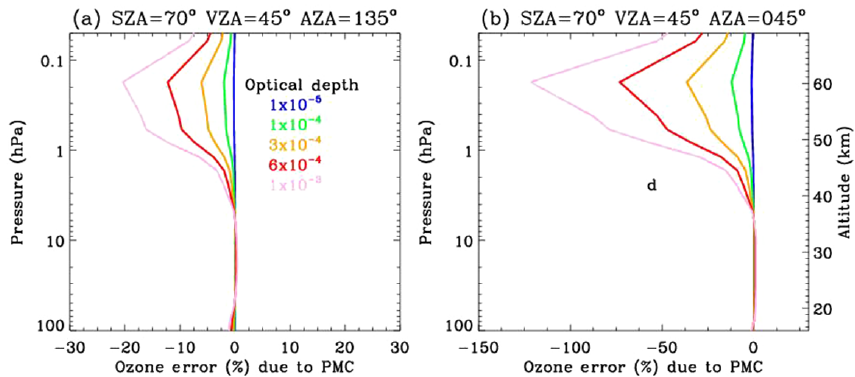
Figure 7. Ozone profile retrieval errors as functions of pressure due to the neglect of PMCs estimated by the optimal estimation approach.